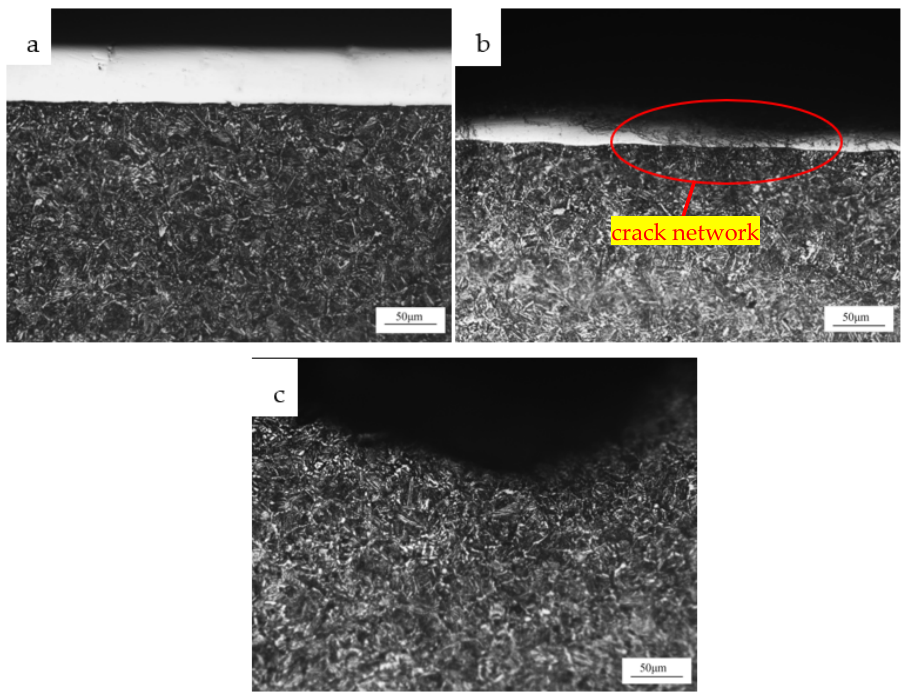
Figure 4. OM observation of structure: ( a ) substrate; ( b ) crack part; ( c ) the cross-section of corrosion pit .